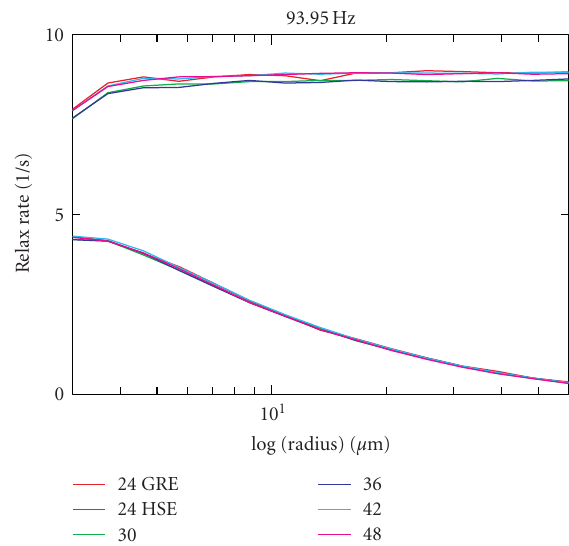
Figure 6: R2/R2 ∗ relaxation rates (in s − 1 ) shown for 9 angles and 18 angles compared to the data for 6 angles between the exterior field and the vessel direction.